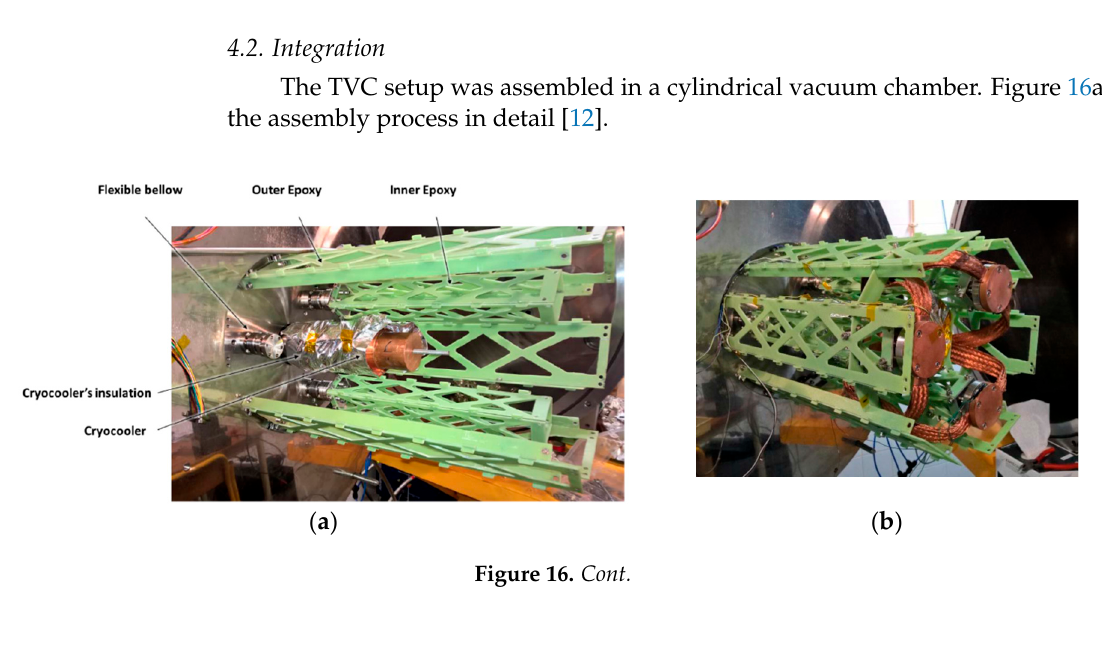
Figure 15. ( a ) Epoxy after the CNC milling process. ( b ) Display of most parts produced using the CNC machine during the workshop.